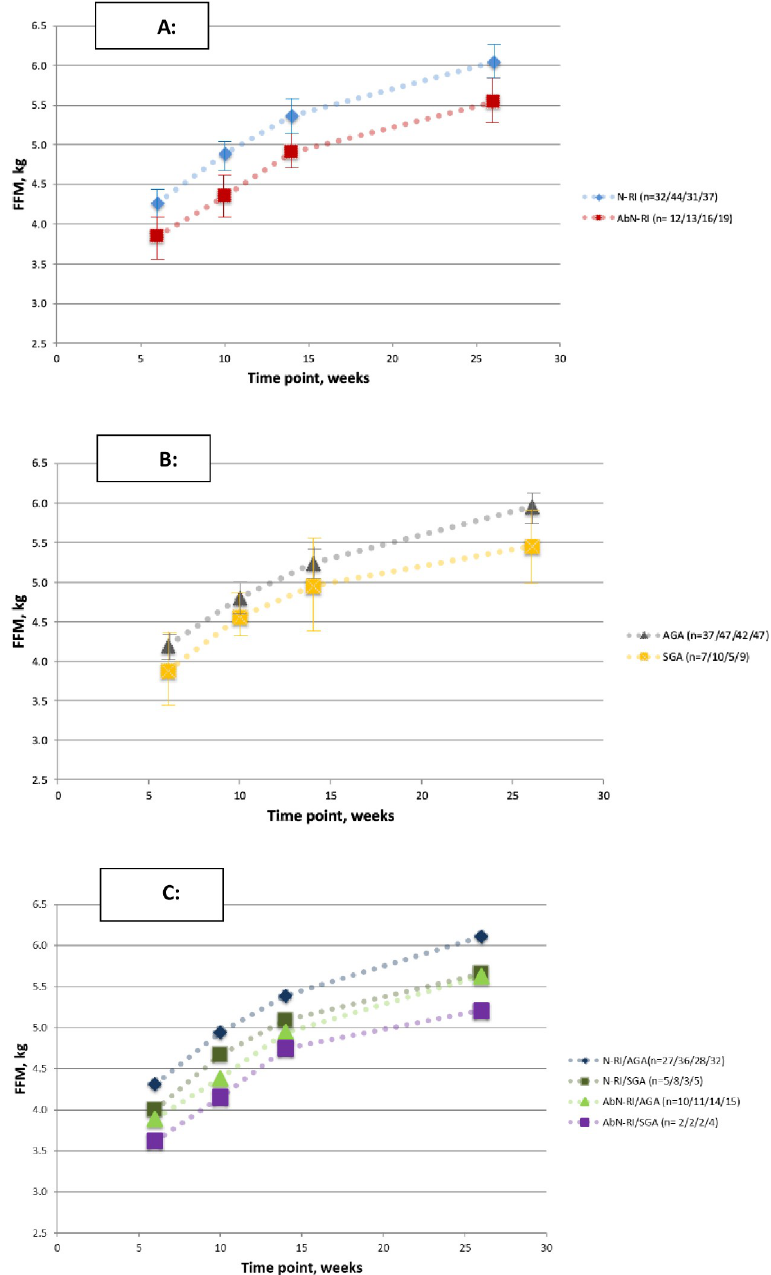
Fig 2. Fat-free mass in infants in the first 6 months of life . (A) Grouped according to normal and abnormal resistance indices (RI) of the umbilical artery Doppler, (B) grouped according to weight at birth in terms of appropriate-for-gestational age (AGA) and small -for-gestational age (SGA), and (C) grouped according to the umbilical artery RI and AGA/SGA classifications. Abbreviations: N-RI = normal resistance index (of umbilical artery Doppler); AbN-RI = abnormal resistance index; AGA = appropriate-for-gestational age weight at birth; SGA = small- for-gestational age weight at birth. Numbers in brackets are the numbers in the group at the 6/10/14/26 weeks’ time points, respectively. Error bars represent the 95% confidence intervals of the